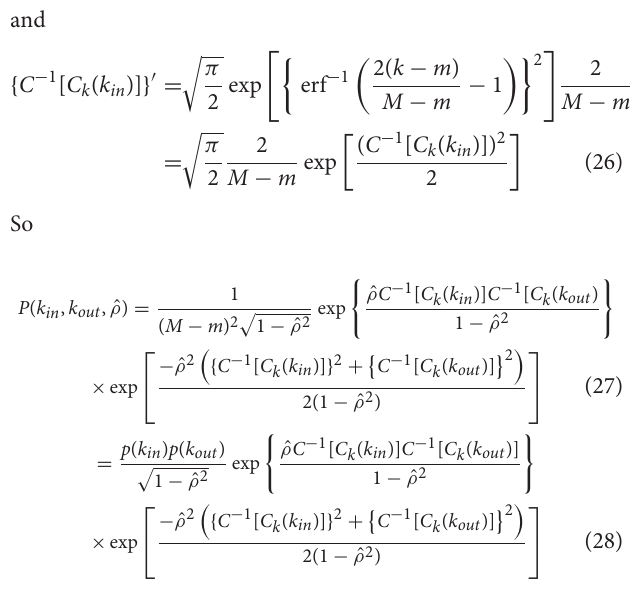
FIGURE 1 | Joint degree distribution P ( k in , k out , Parameters: m